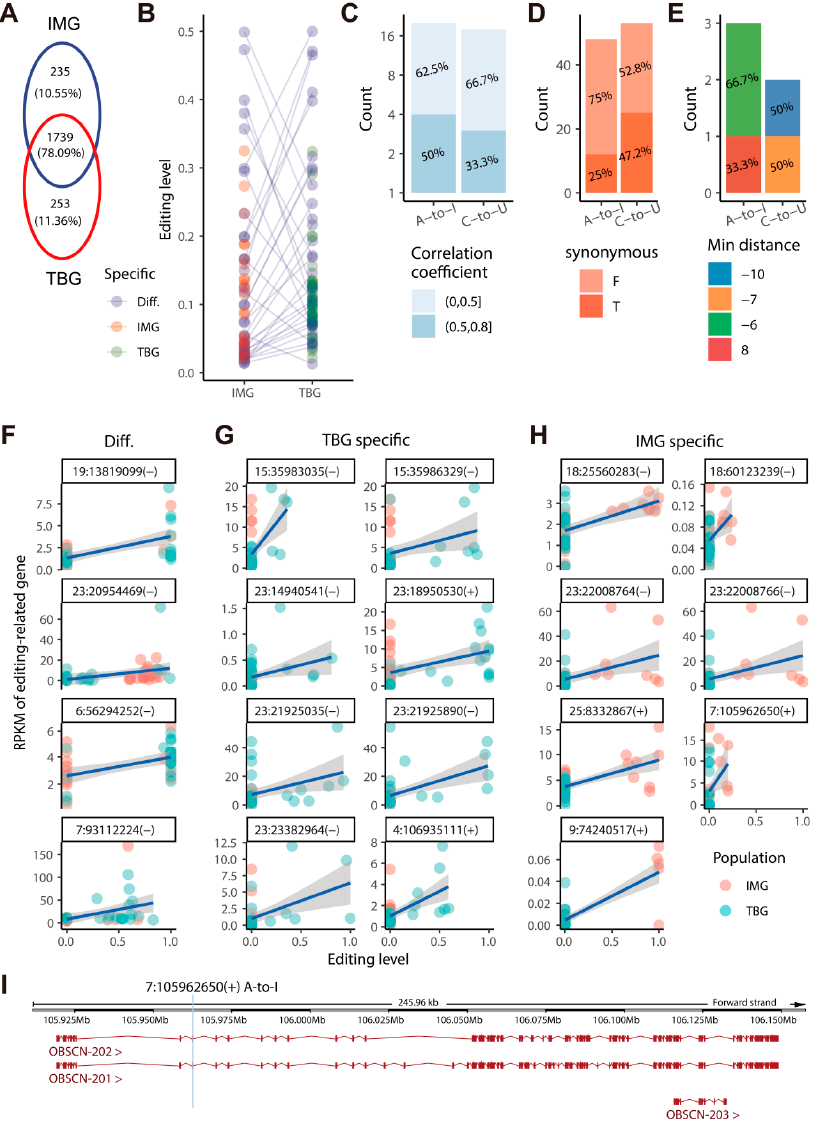
Figure 6. Population-specific RNA editing sites (pSESs) in goats. ( A ) Sharing numbers of RESs among IMG and TBG populations. ( B ) Population-differential editing sites (pDESs) among IMG and TBG. ( C ) Correlation between the pSESs and pDESs-related genes and A-to-I and C-to-U editing. ( D ) Protein-coding changes after population-specific and differential A-to-I and C-to-U editing. ( E ) Distribution of min distance to the exon of pSESs and pDESs. ( F – H ) Correlation between ex- pression levels of editing-related genes and editing levels of pDESs ( F ), TBG pSESs ( G ), and IMG pSESs ( H ). ( I ) The annotated IMG pSESs editing-related gene OBSCN in the goat genome. F: False, non-synonymous, T: True,